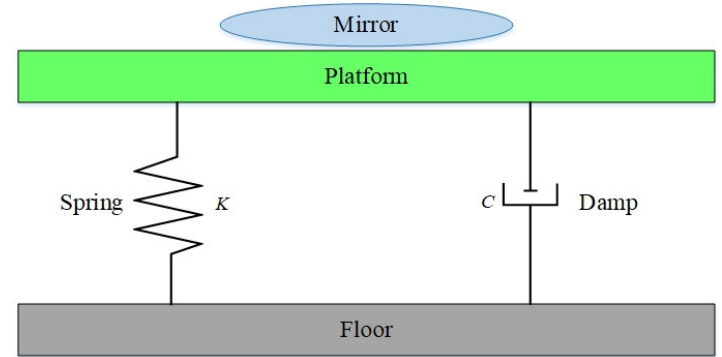
Figure 3. Composition of a passive vibration isolation system.